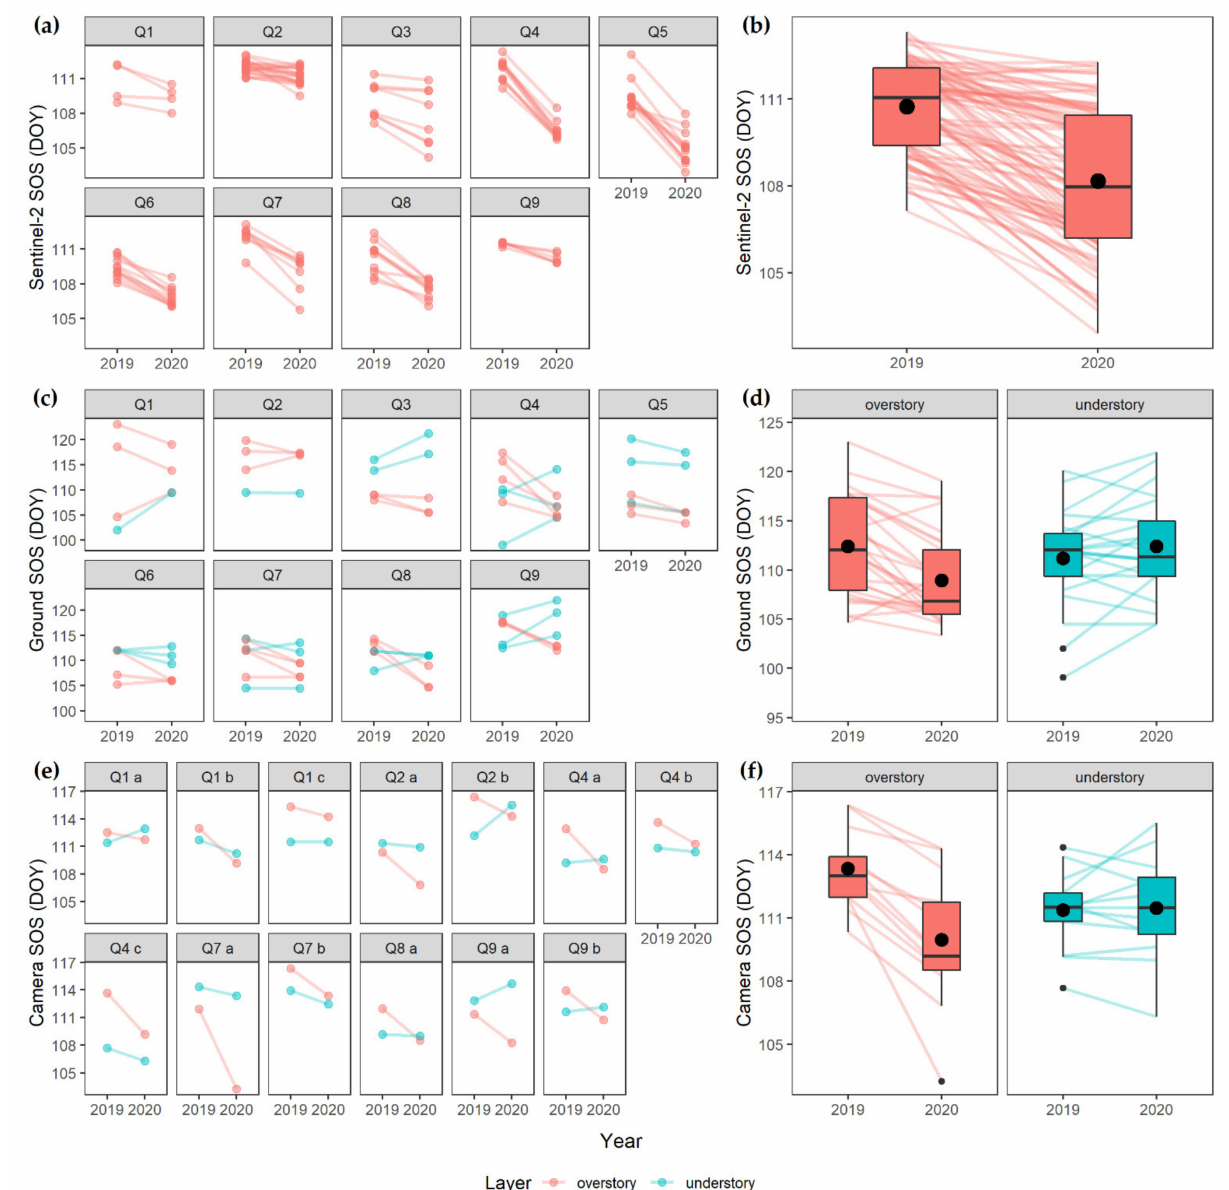
Figure 2. Differences in SOS for 2019 and 2020, overstory and understory, by the three different methods: Sentinel-2 observations ( a , b ), ground observations ( c , d ), and camera observations ( e , f ). In panel ( a , c ), these observations are visualized per quadrant and, in panel ( e ), per camera site, as indicated with a small letter behind the quadrant code. Dots represent individuals ( a , c ) or cameras ( e ). In panel ( b , d , f ), these dots are summarized in boxplots per year, with large black dots representing the mean and small black dots representing outliers. Lines represent individuals ( a – d ) or cameras ( e , f